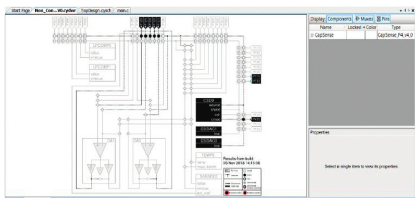
Figure 5: Analog channel configuration for